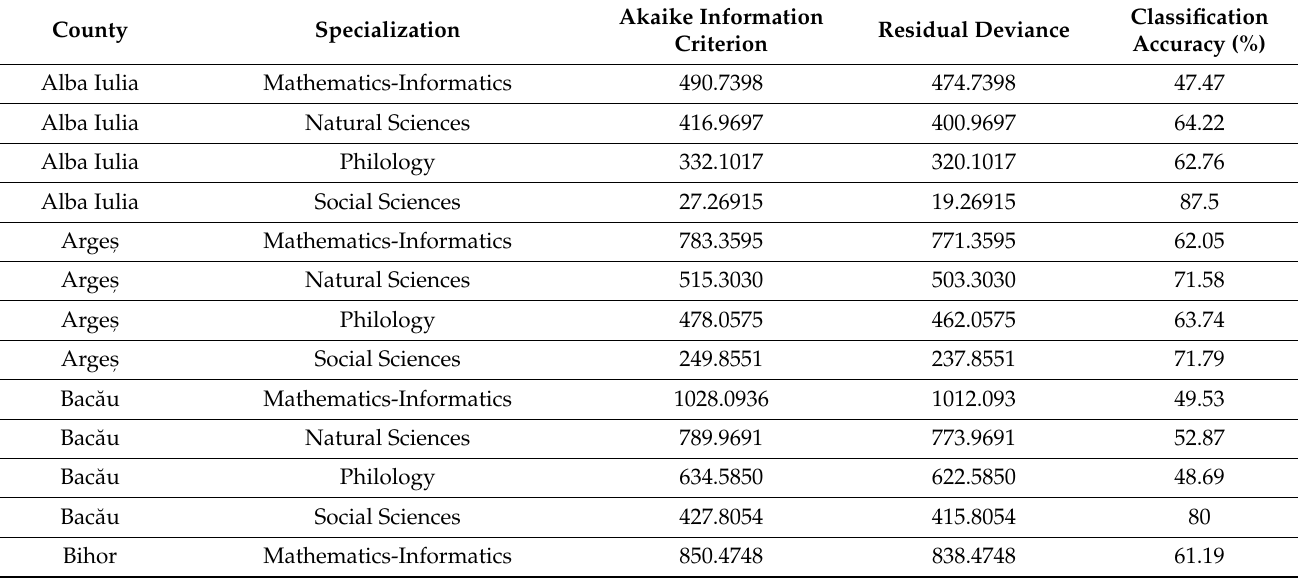
Table A1. Summary of multinomial regression